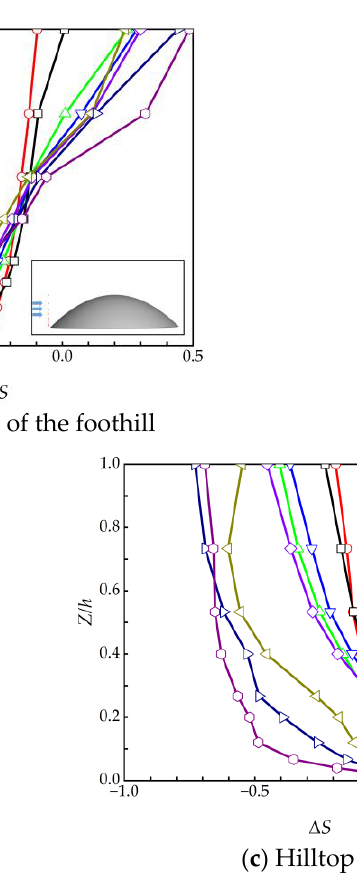
Figure 10. Speedup ratio of the hill with different slopes.